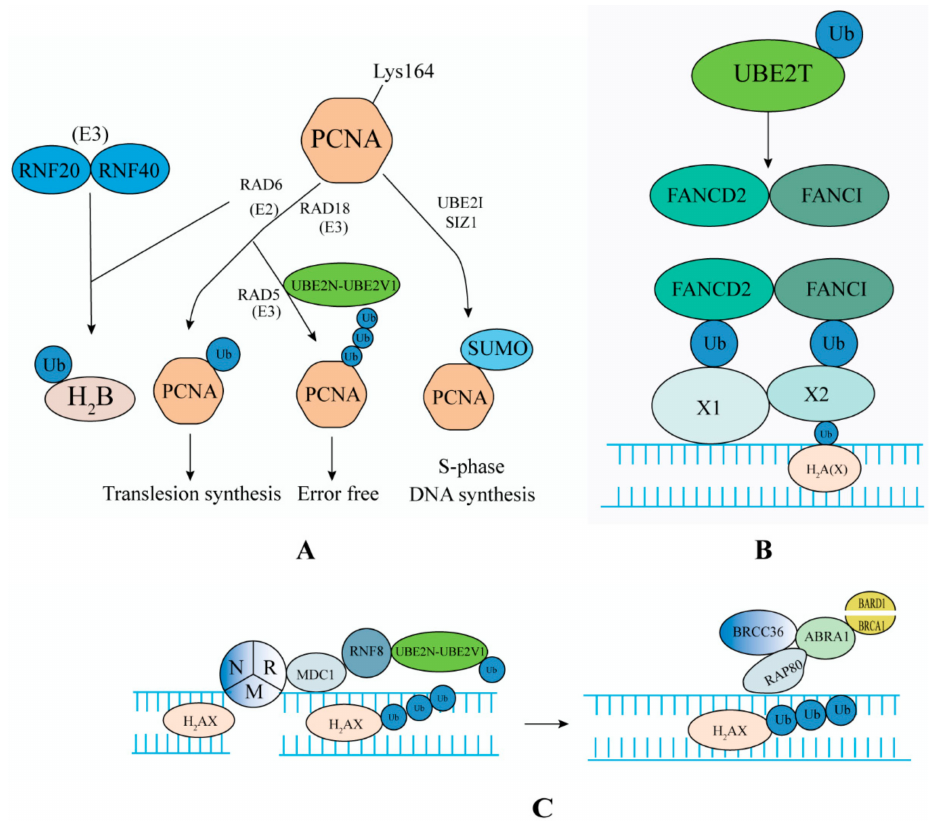
Figure 3. E2s participate in the DNA repair pathway. ( A ) E2 ubiquitinates proliferating cell nuclear antigen (PCNA) to participate in the DNA replication and repair process. ( B ) E2 ubiquitinates the FANCD2 and FANCI complex to participate in the FA pathway. ( C ) E2 ubiquitinates H2A(X) to participate in the DNA replication and repair process. UBE2D3 can also participate in the above ( A , C ) processes